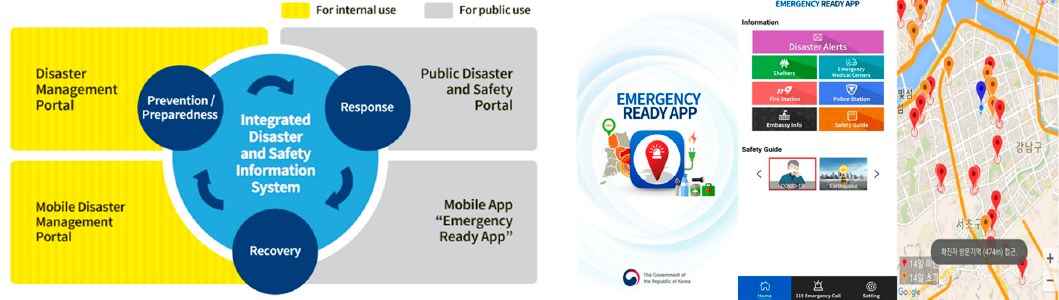
Figure 6. Korean integrated disaster safety and information system, and emergency